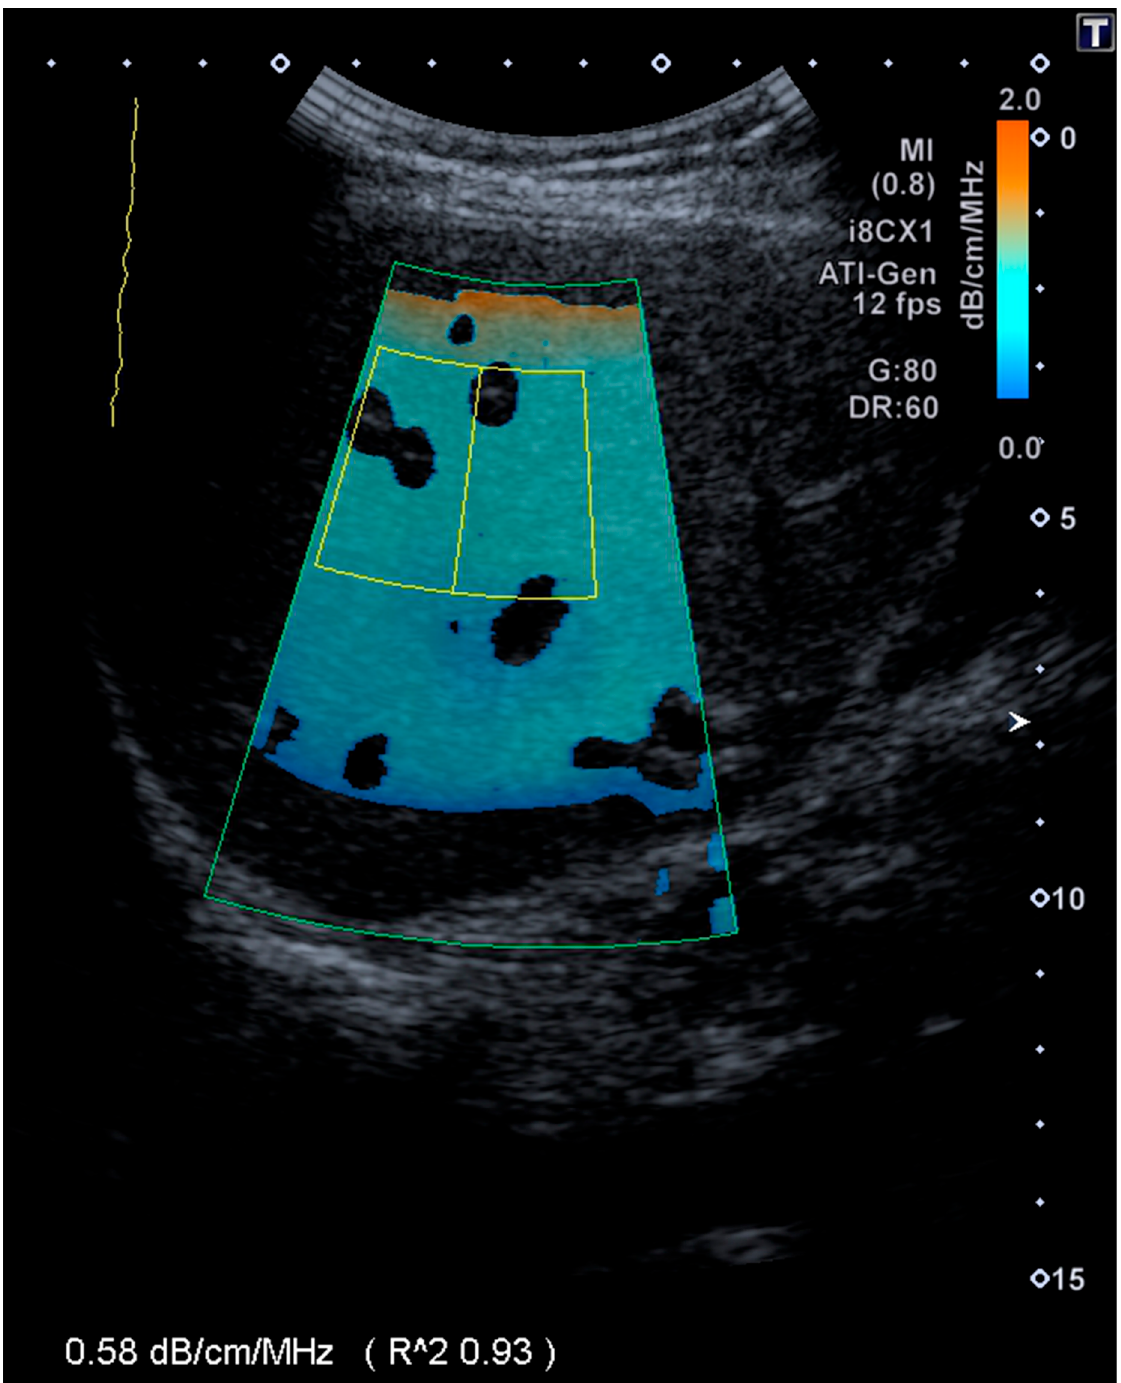
Figure 2. A region of interest (ROI, yellow marked area) is placed below the capsular artifact, which is visualized in orange color. The measured attenuation coefficient is 0.58 dB/cm/MHz, indicating the absence of steatosis.